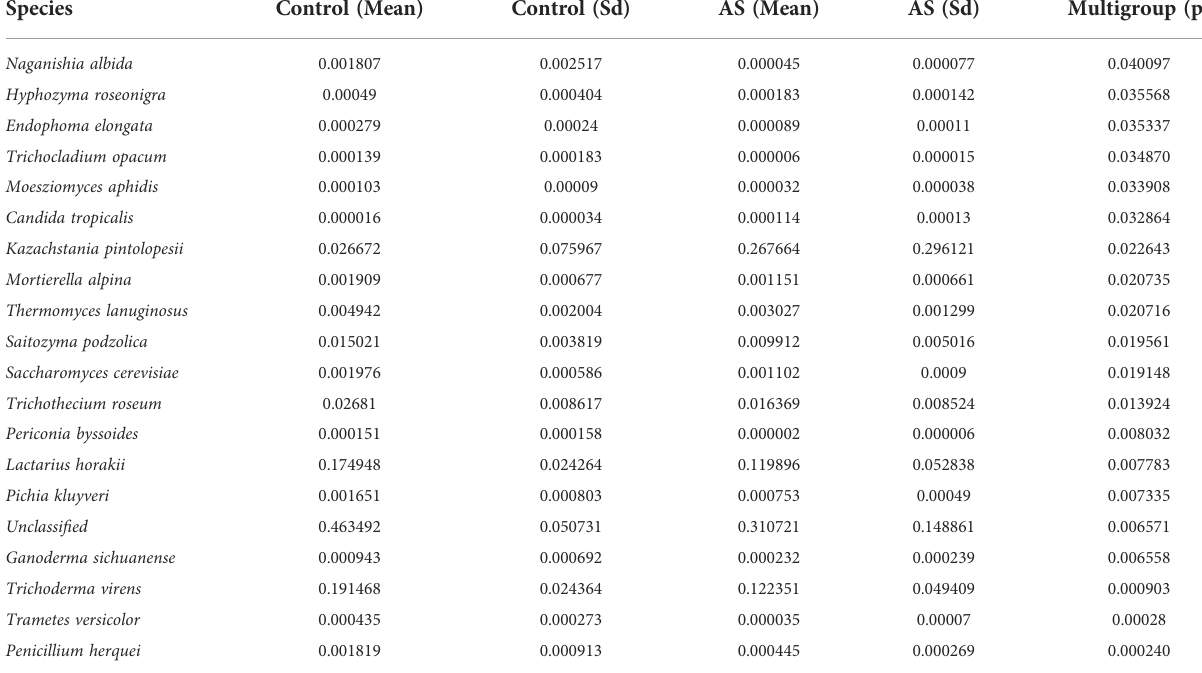
TABLE 3 ANOVA (Analysis of Variance) at species level of mycobiota ( p <0.05).